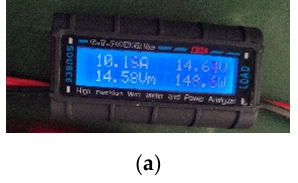
Figure 8. ( a ) Watt meter; ( b ) electrical tunable.